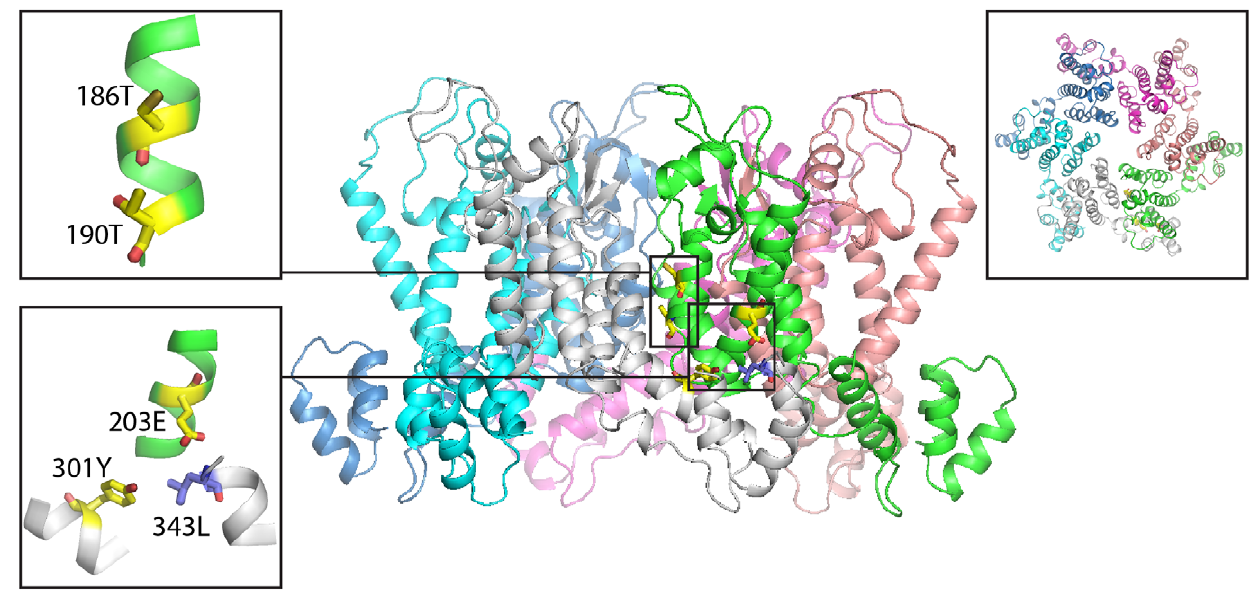
Figure 2. Spatial arrangement of the two top-scoring pairs in a side view of the hexameric unit-cell of the mature capsid lattice (PDB ID 3mge). A top view is shown in the top-right inset. The left insets highlight the top-scoring pairs of residues, which are shown in the sticks representation (yellow carbons). The side chain of 343L, which has previously been demonstrated to be crucial for formation of the mature lattice, is also shown (blue carbons).